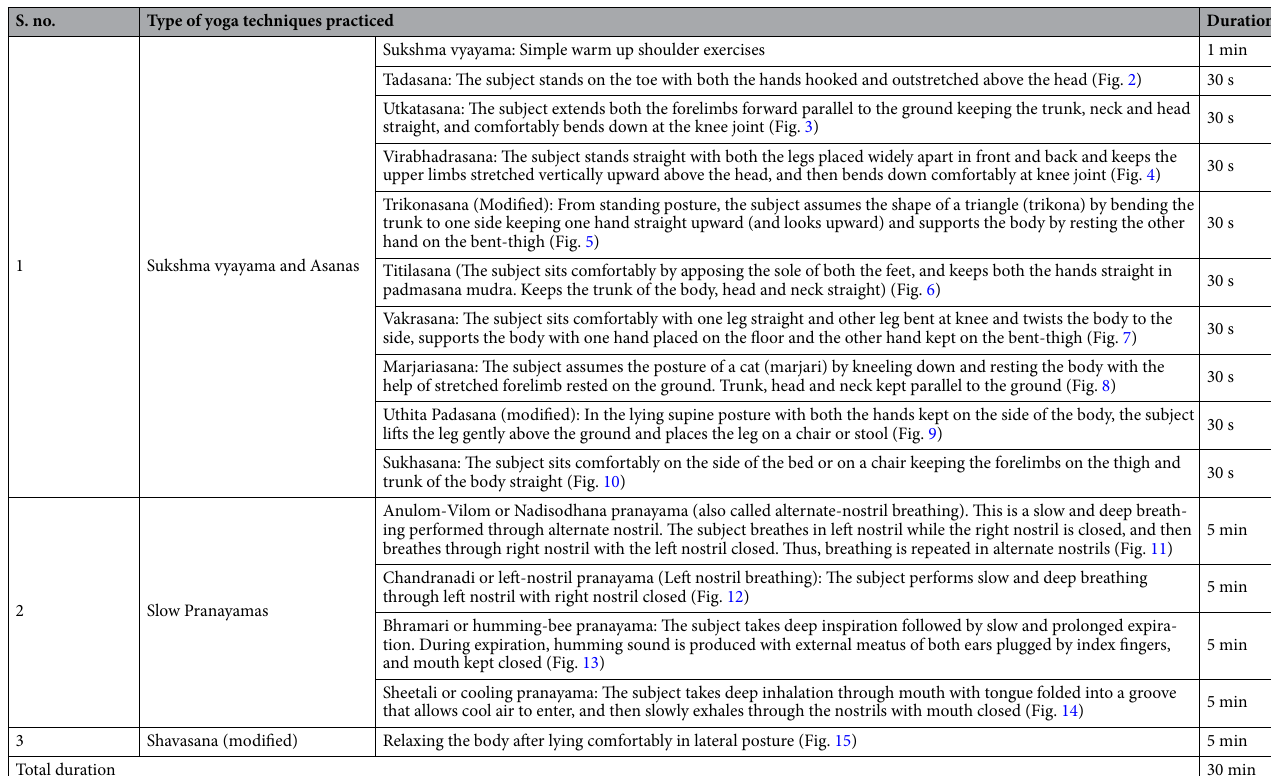
Table 2. The schedule of yoga intervention. Pictures in the Figs. 2, 3, 4, 5, 6, 7, 8, 9, 10, 11, 12, 13, 14 and 15 are photographs of a pregnant woman in the study group during her practice of different yoga techniques, at 34th week of